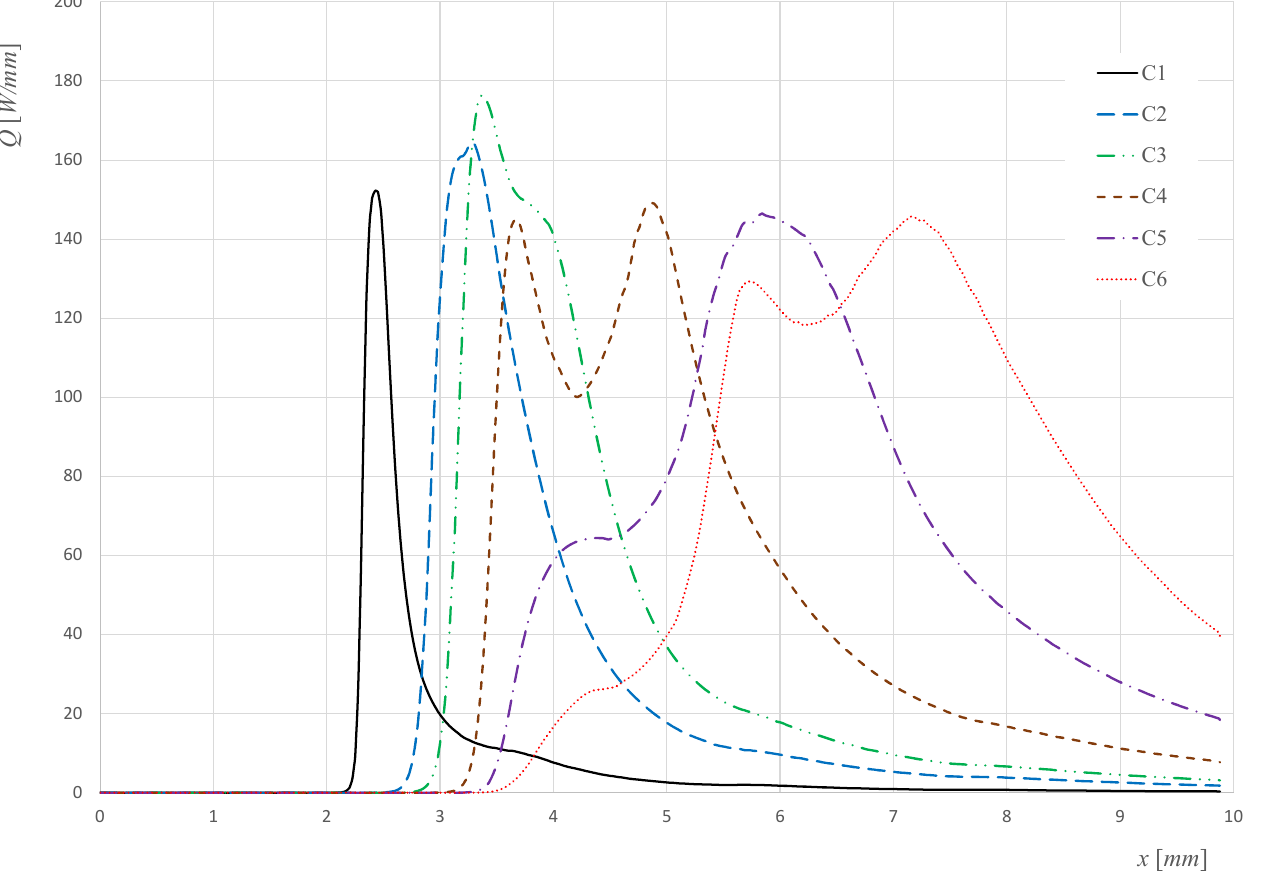
Figure 7. Heat release rate profiles along the centerline axis for different inlet